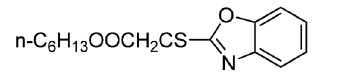
Fig. 36 The structural formula of the compound.